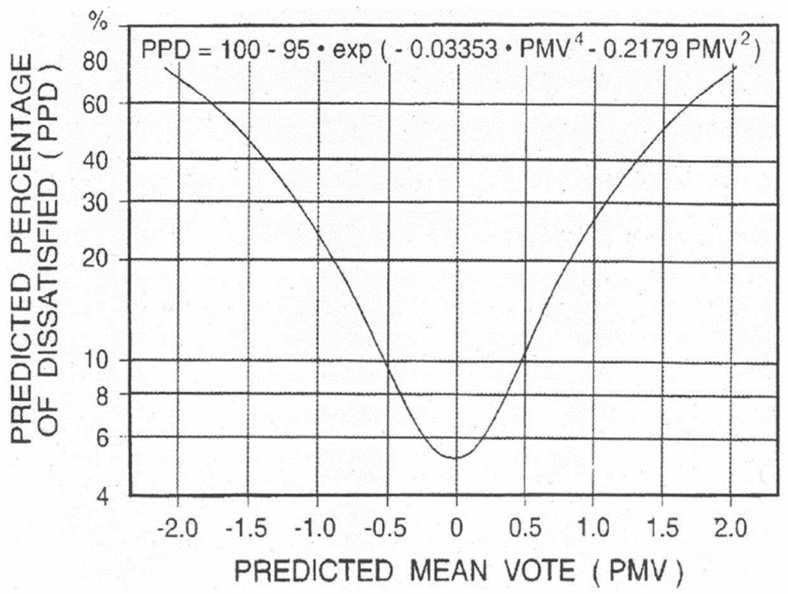
Figure 6. PPD, PMV